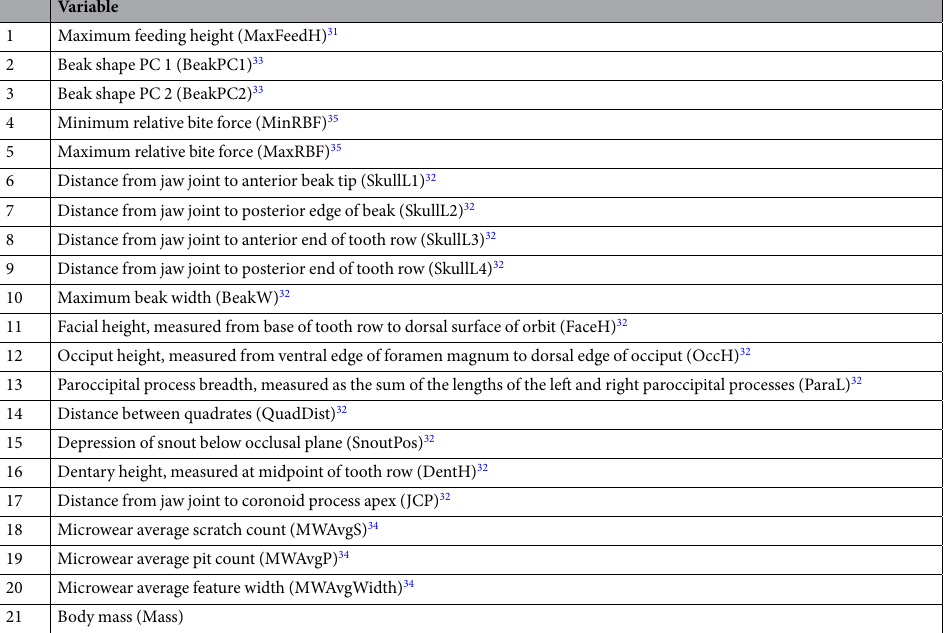
Table 1. Variables used in this study. Abbreviations correspond to entries in Supplementary Data